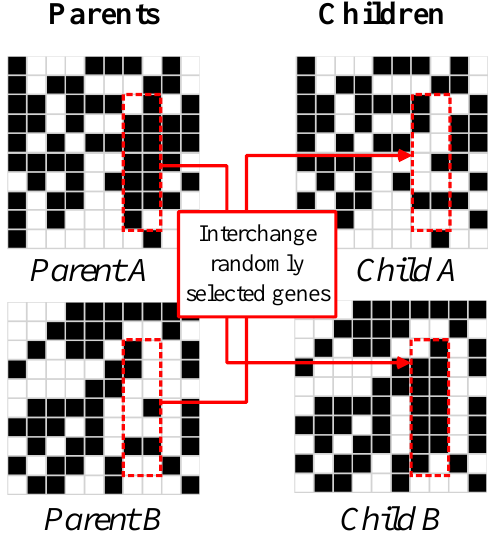
Figure 3. Illustration of 2D binary crossover.